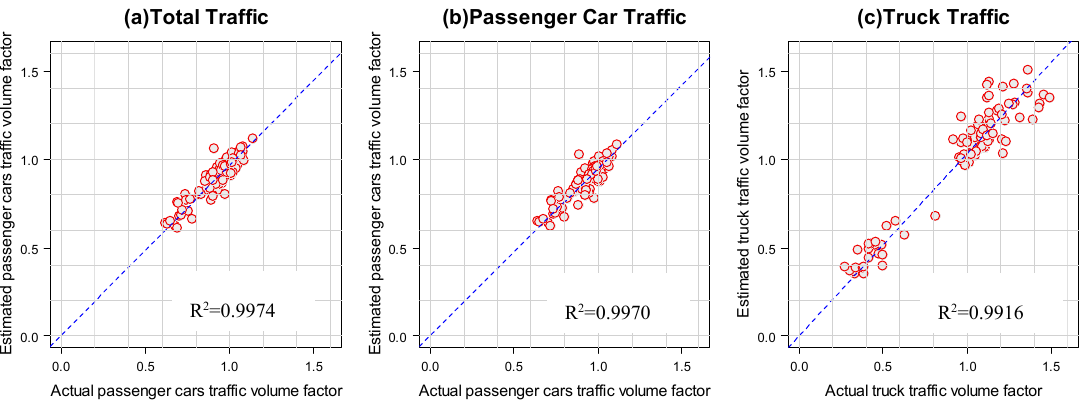
Figure 15. The accuracy of temporal transferability for naive regression model at Leduc Highway 2A.